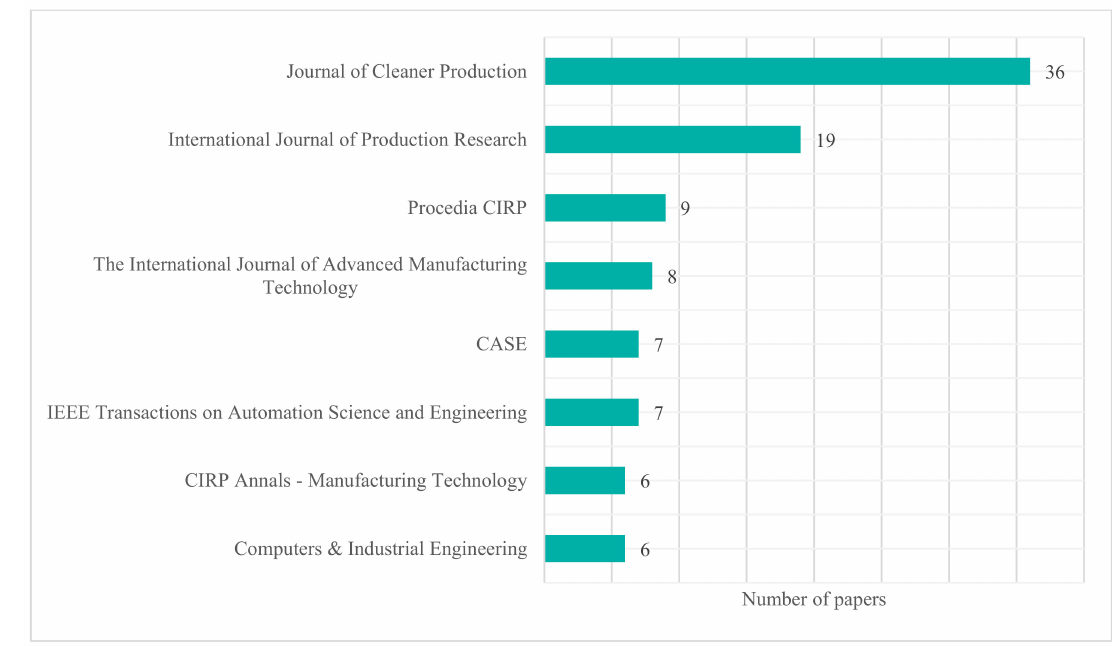
Figure 2. Journal/number of articles graph.